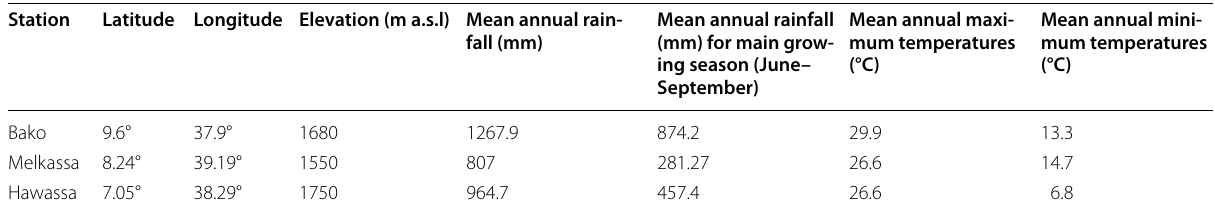
Table 1 Climate characteristics (1980–2010) for the three study areas (Bako, Melkassa and Hawassa stations)